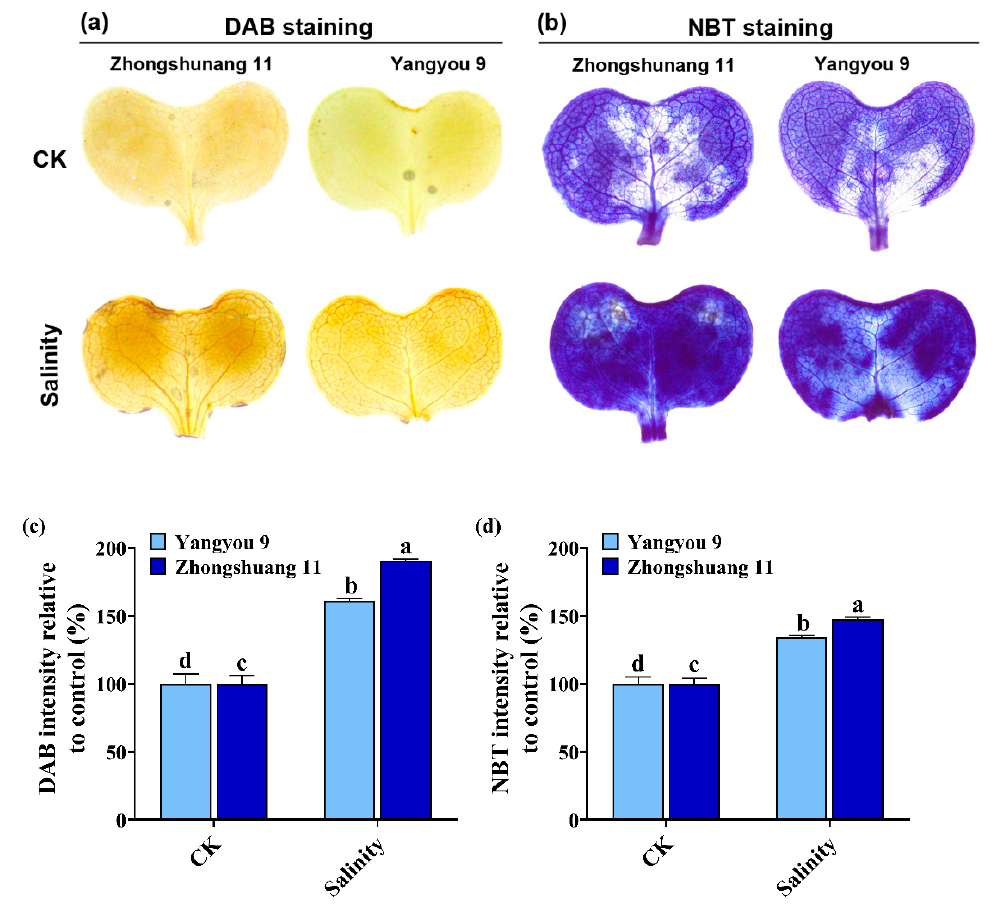
Figure 4. ROS accumulation in Yangyou 9 and Zhongshuang 11 leaves with ( a ) 3, 3-diaminobenzidine (DAB), ( b ) nitro blue tetrazolium (NBT), ( c ) DAB intensity relative to control (%), and ( d ) NBT intensity relative to control (%) under NaCl (150 mM). Bars represent ± SE of three replicates. Letters (a, b, c and d) on vertical bars represent significant differences between cultivars and treatments according to Duncan’s multiple range test (DMRT) at p < 0.05.